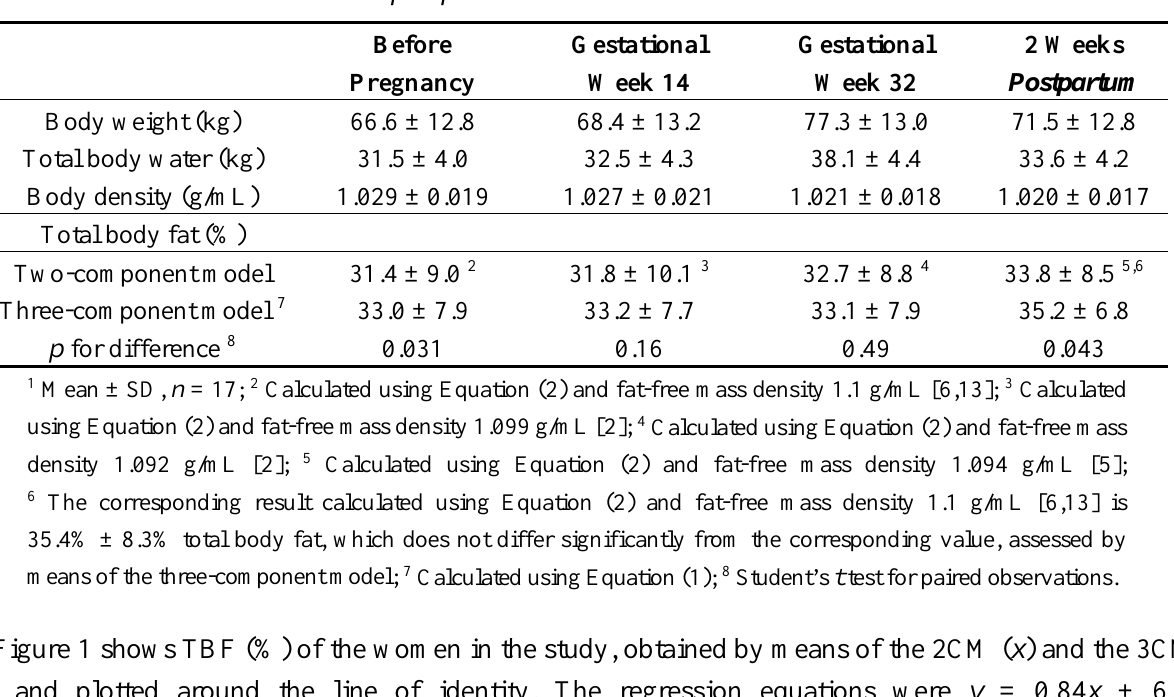
Table 1. Body weight, total body water, body density and total body fat assessed by means of two- and three-component models in healthy women [12] before pregnancy, at gestational weeks 14 and 32 and 2 weeks postpartum 1